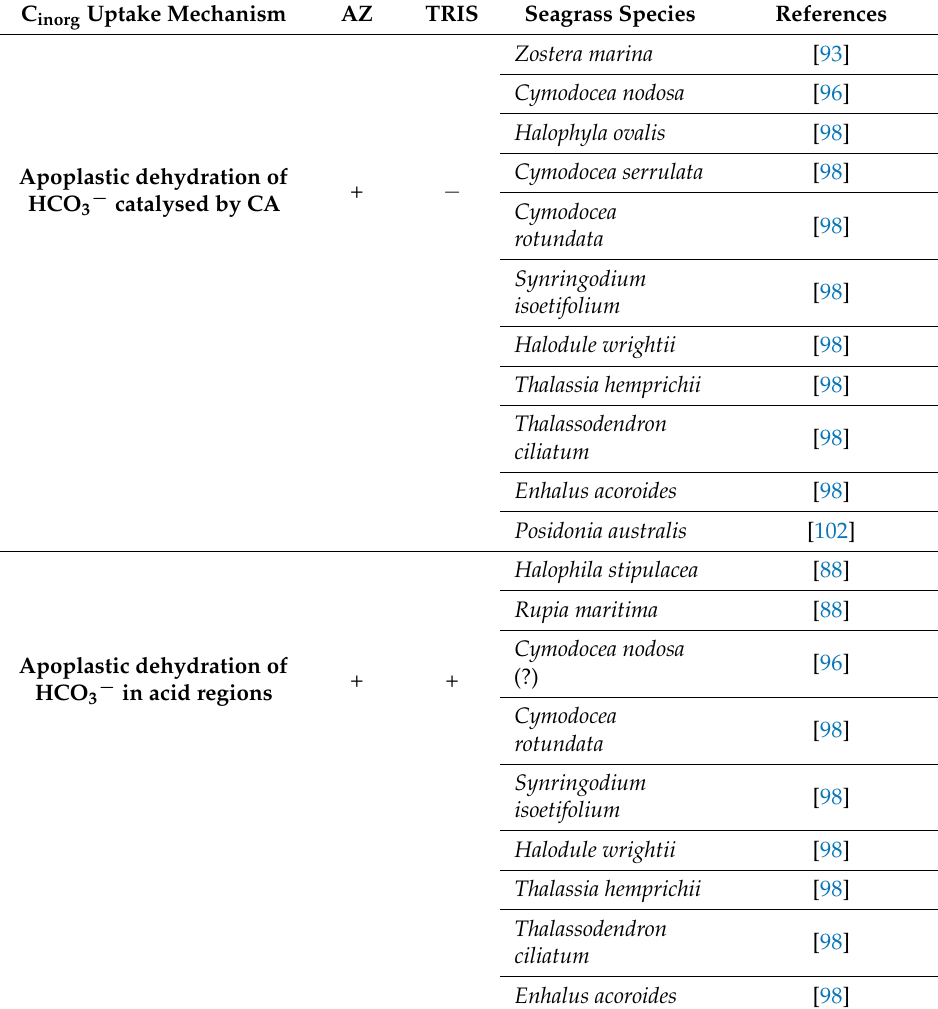
Table 1. C inorg uptake mechanisms proposed for several seagrass species based on their photosynthetic sensitivity to TRIS and AZ. Question mark (?) denotes that the mechanism is partially supported by available